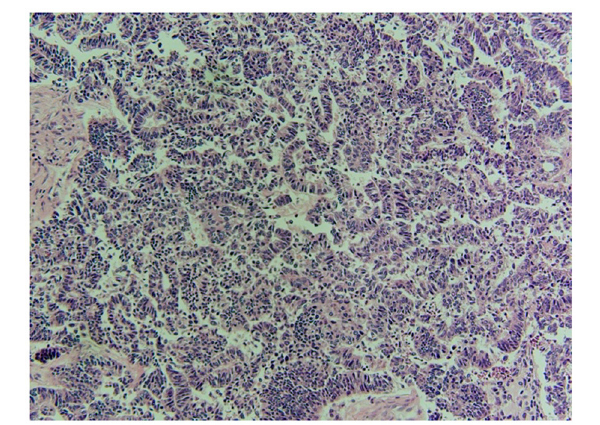
FIGURE 9 | Chondroid portion of the tumor as well as cartilaginous matrix and various shapes/sizes of chondrocytes.